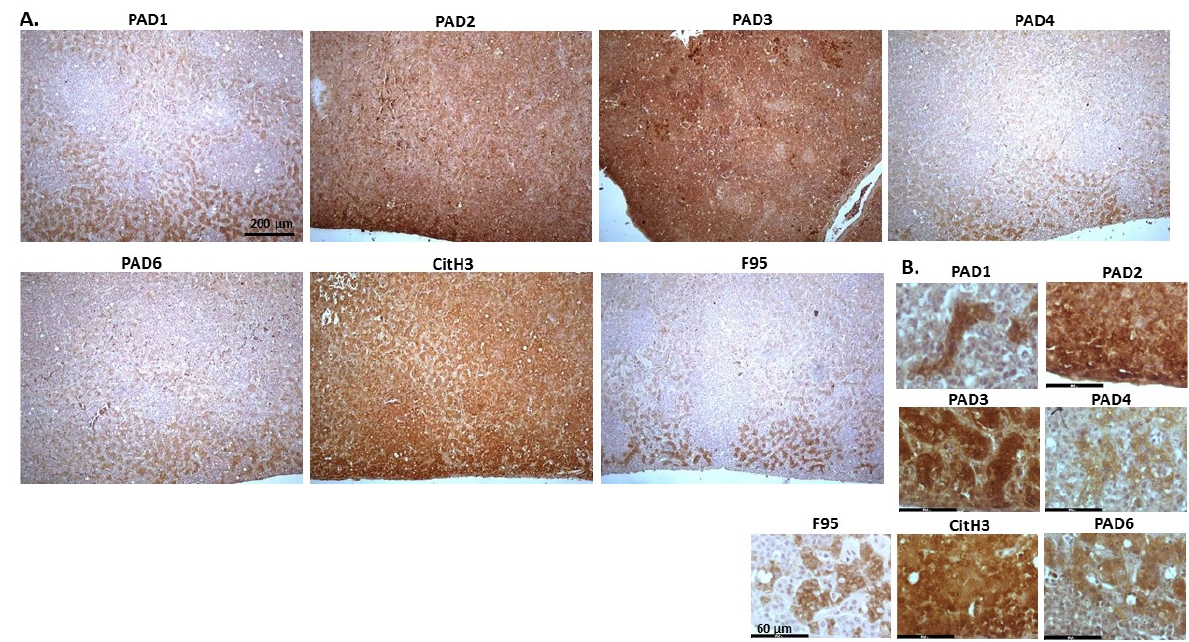
Figure 4. Regent parrot, lymphoma in liver and spleen. Cadaver, male bird. Tumour was observed in various organs, including liver, spleen, heart, kidney, adipose tissue and skin. Diagnosis: dis- seminated malignant round cell tumour, probable lymphoma. ( A ) Overview images for PAD1, 2, 3, 4, 6, CitH3 and F95 stainings of serial tissue sections; scale bar represents 200 µ m for all images; 10 × objective. ( B ) Higher magnification shown for each staining from the images in ( A ); scale bar represents 60 µ m for all images; 40 × objective.